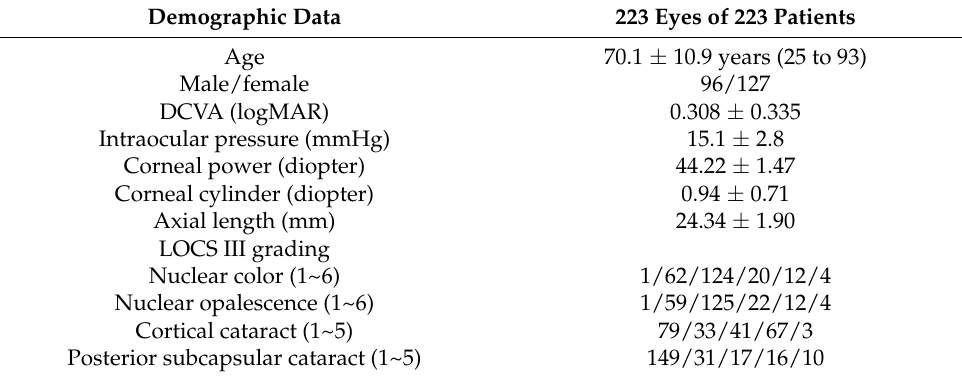
Table 2. Demographic data of eyes undergoing cataract